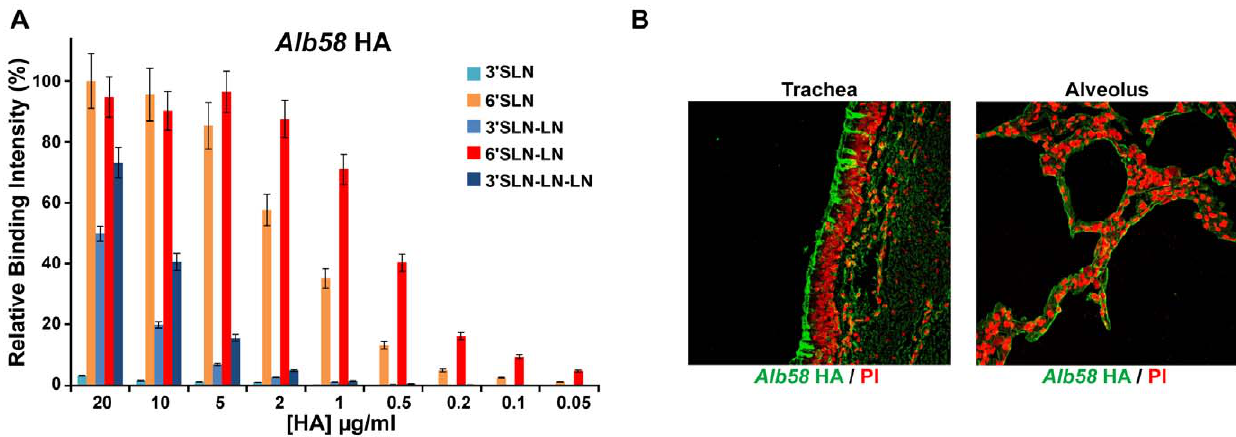
Figure 1. Glycan receptor-binding specificity of Alb58 HA. A , shows dose-dependent direct glycan array binding of Alb58 HA which shows high affinity binding to human receptors in comparison with avian receptor binding. B , shows extensive staining of apical surface of human tracheal epithelia and observable staining of alveolar tissue section by Alb58 HA (in green ) shown against propidium idodide staining (in red ).